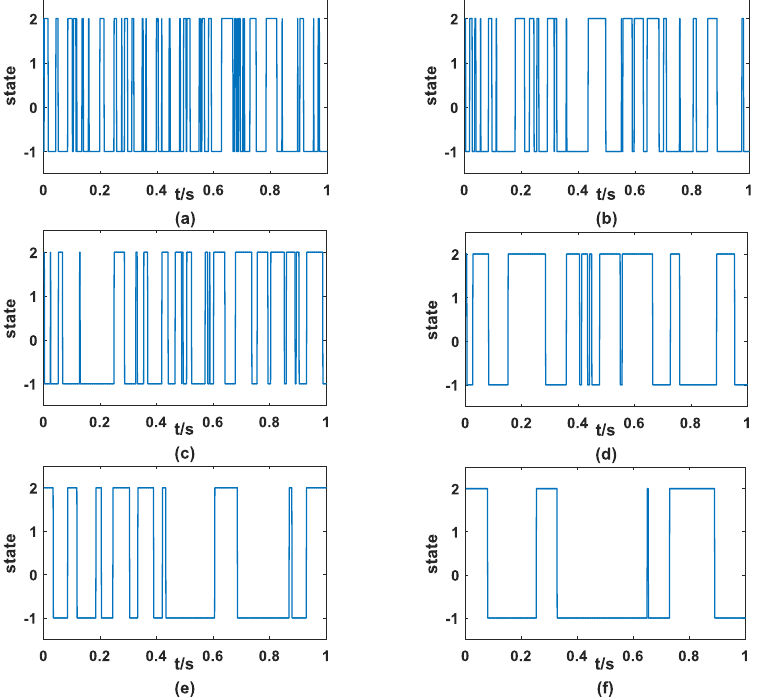
Figure 2. Dichotomous noise ( a = 2, b = − 1) ( a ) D = 0.01 ( b ) D = 0.02 ( c ) D = 0.03 ( d ) D = 0.04 ( e ) D = 0.05 ( f ) D = 0.06.